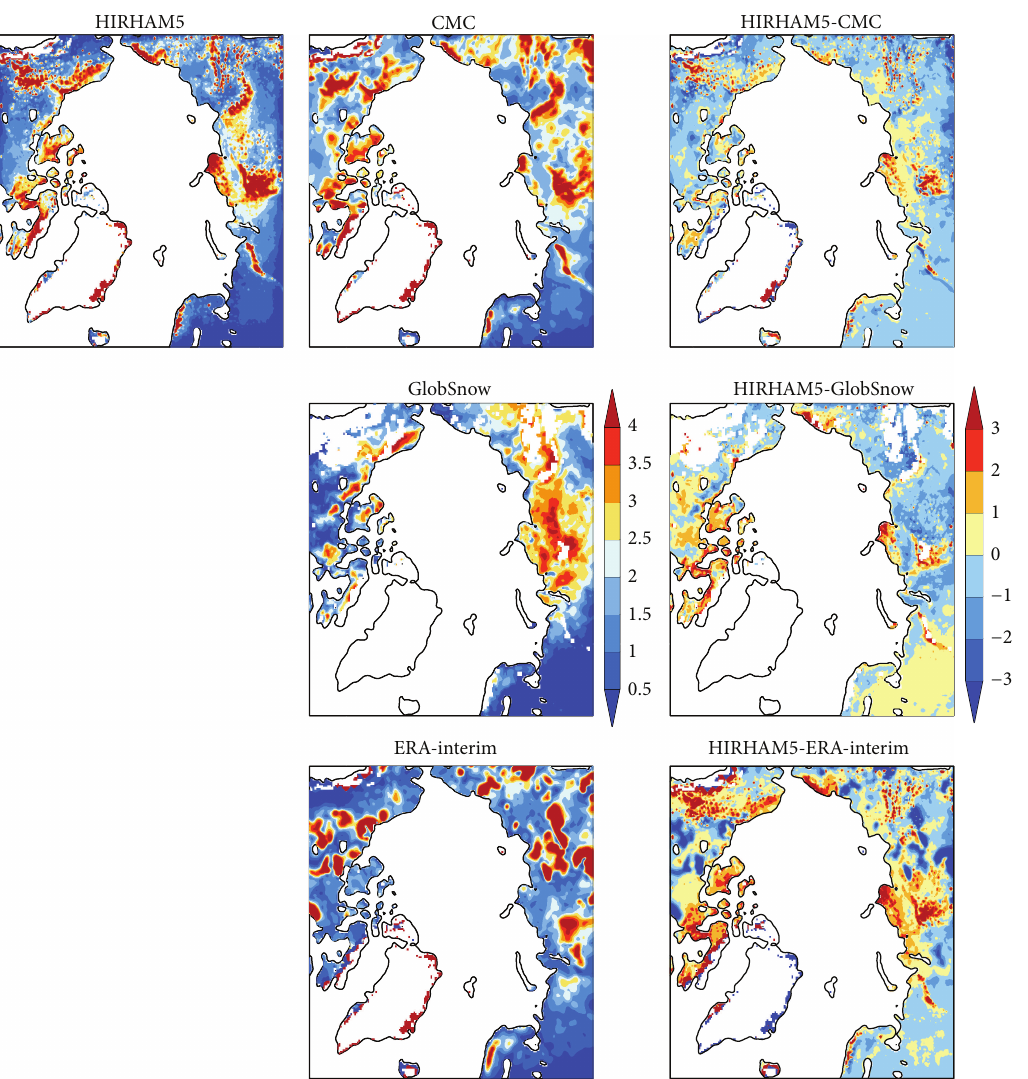
Figure 4: Snow water equivalent (cm) averaged over 2008–2010 for autumn derived from HIRHAM5, CMC, GlobSnow, ERA-Interim and their corresponding differences “HIRHAM5 minus CMC”, “HIRHAM5 minus GlobSnow”, “HIRHAM5 minus